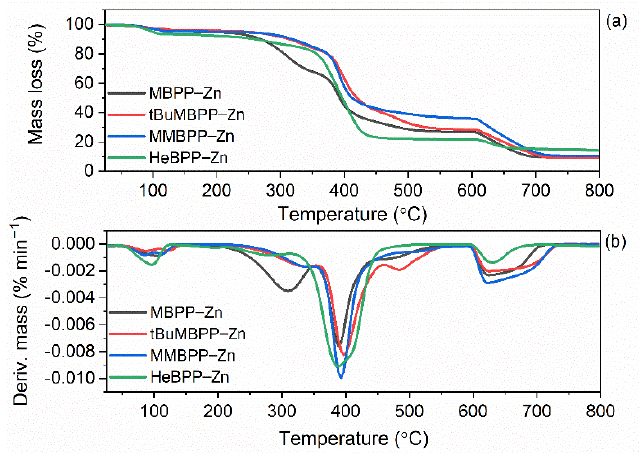
Figure 14. Thermal stability of zinc complexes with 1,3-diketones: ( a ) TG curves; ( b ) DTG curves. Table 9. Thermal stability of zinc complexes with 1,3-diketones (T 5% , decomposition temperature at 5% of the mass change; T DTG , DTG peak temperature; standard deviations (SD): T 5% , T DTG ± 2 °C). Zinc Complex T 5% (°C)